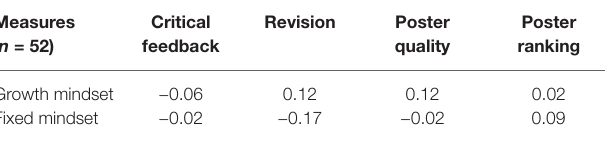
TABLE 3 | Spearman correlations between mindset and learning measures (Assign